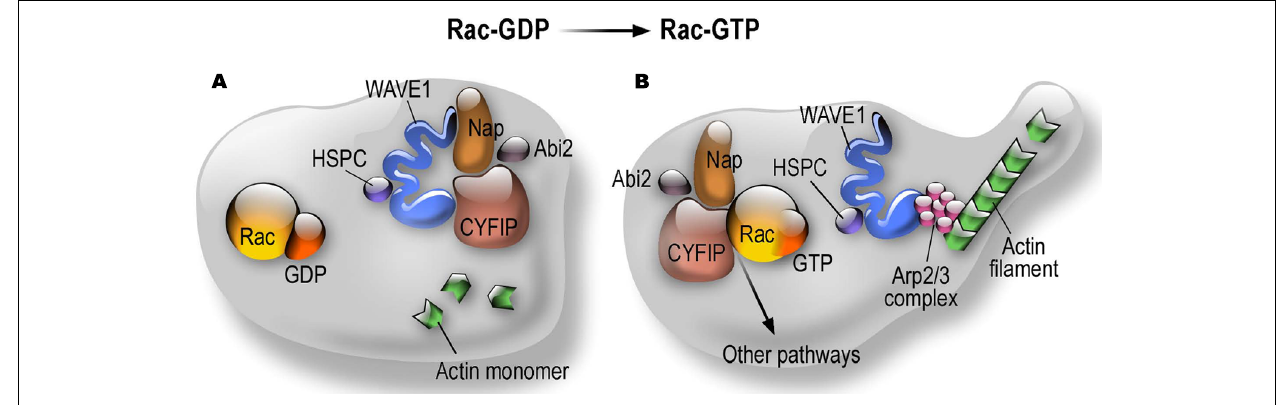
FIGURE 1 | Dynamics of CYFIP Proteins in the context of theWAVE complex and actin polymerization. (A) Structural organization of theWRC in the Rac-GDP condition; (B) Structural organization of theWRC in the Rac-GTP condition.